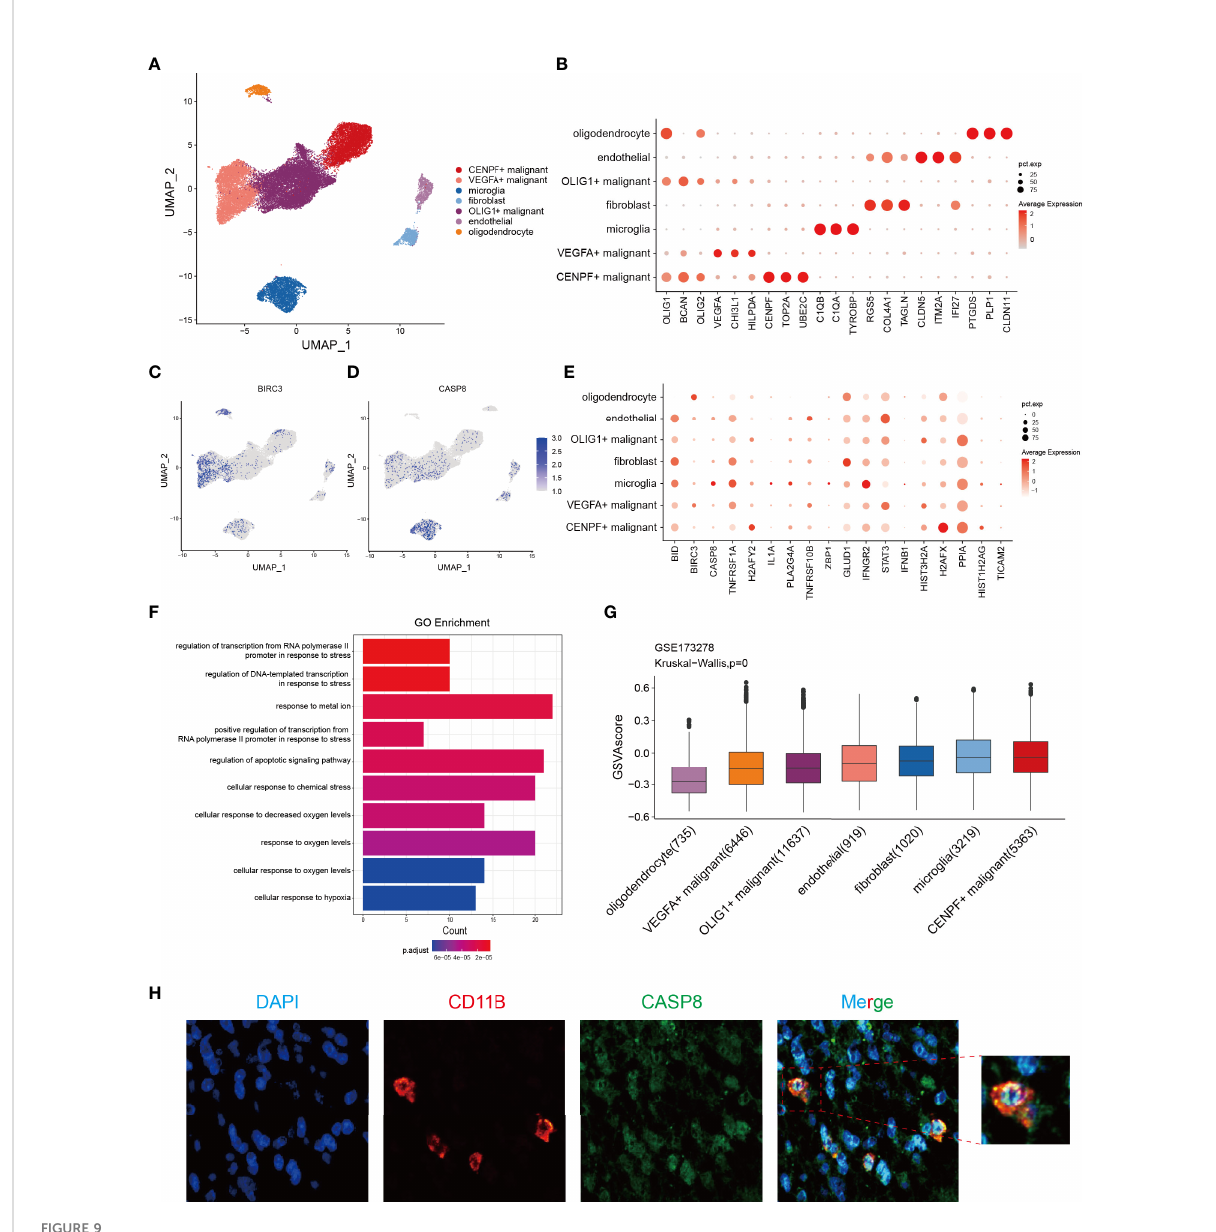
FIGURE 9 Identi fi cation of the potential genes associated with necroptosis in glioma through the scRNA-seq analysis. (A) Cells were divided into 7 cell subsets based on the marker gene expression. (B) Respective marker genes of the 7-cell subsets. (C, D) Expression of BIRC3 and CASP8 in different cell subsets, with a speci fi c expression in VEGFA + malignant cells and microglia, respectively. (E) Expression levels of 18 NRGs in the NRS from 7 different cell subsets. (F) GO enrichment analysis of signi fi cant DEGs in VEGFA + malignant cell subsets versus other cell subsets. (G) The GSVA score of the necroptosis pathway in each cell subset. (H) IFH assay con fi rmed the localization of CASP8 in microglia (red fl uorescent: anti-CD11B, microglia marker; green fl uorescent: anti-CASP8; blue fl uorescent: DAPI,